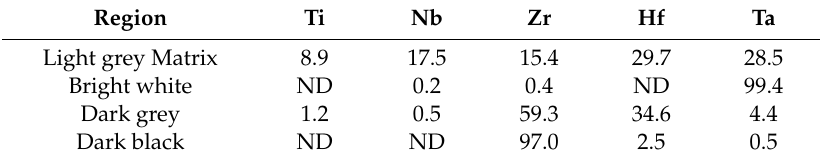
Table 5. Chemical composition (in wt.%) of the alloy compact prepared from pure elements. Region